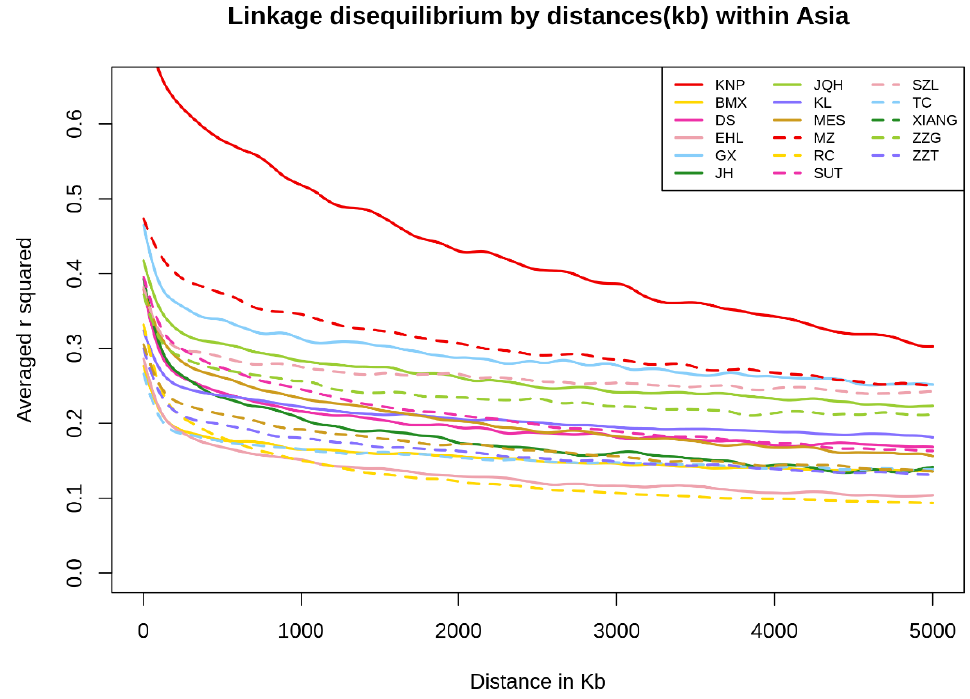
Figure 6. Average r 2 values for the Asian breeds: The Y -axis range was limited to 0–0.65 for easy comparison of the linkage disequilibrium (LD) values among all breeds. (Bamaxiang (BMX), Dongshan (DS), Erhualian (EHL), Ganxi (GX), Jinhua (JH), Jiangquhai (JQH), Kele (KL), Korean Native (KNP), Meishan (MES), Min (MZ), Rongchang (RC), Sutai (SUT), Shaziling (SZL), Tongcheng (TC), Xiang Pig (XIANG), Tibetan Gansu (ZZG) and Tibetan Tibet (ZZT).)